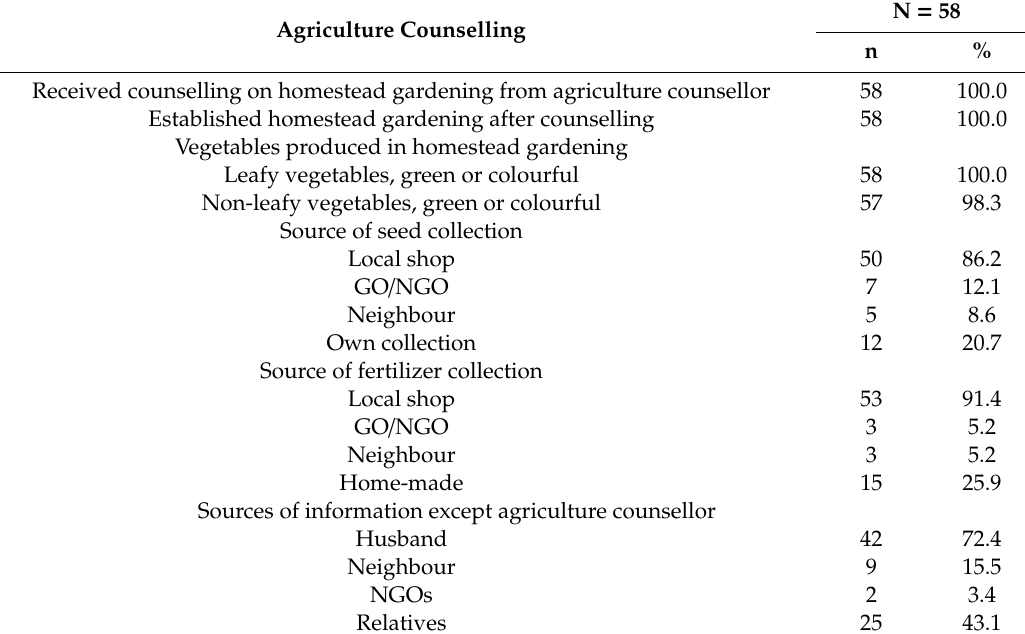
Table 3. Feasibility of agriculture counselling on homestead